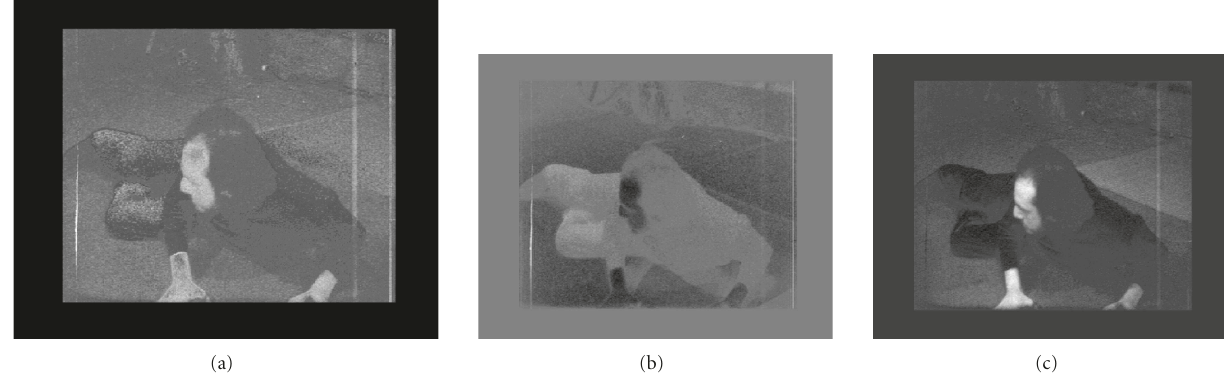
Figure 5: (a) Magenta component of the image in Figure 2. The three scratches are visible as bright defects. (b), (c) Chroma components (Cb and Cr, resp.) of the YCbCr color space: the three scratches are di ff erently perceived. In particular, the red scratch is slight in the Cb component while the blue scratch leaves a black line in the Cr component.